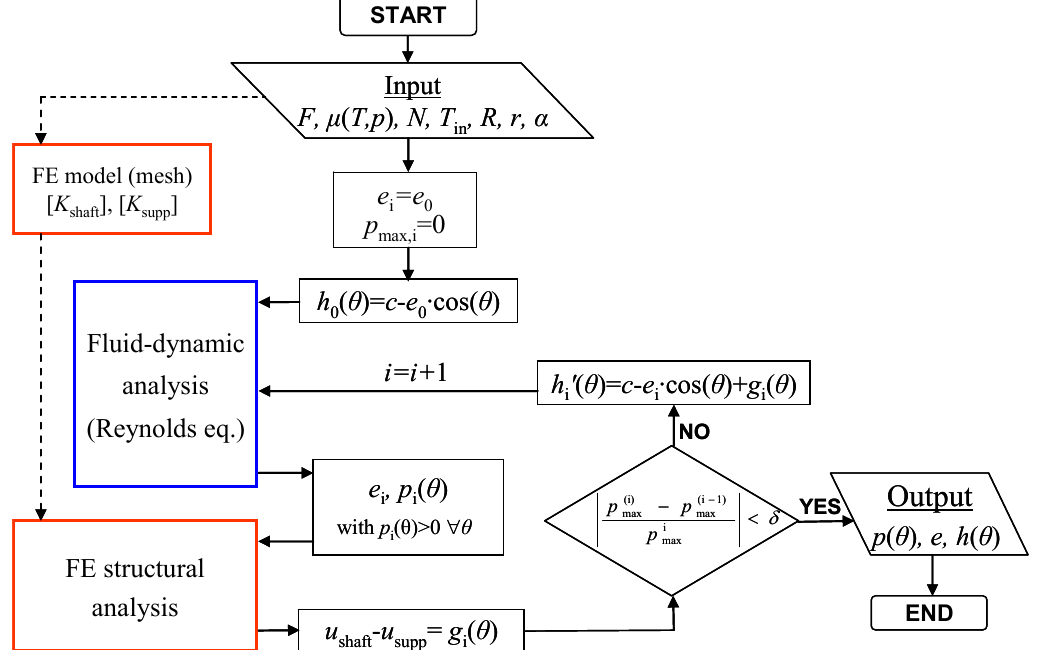
Figure 4: Sketch of the numerical algorithm for fluid-dynamic and structural numerical analysis of journal